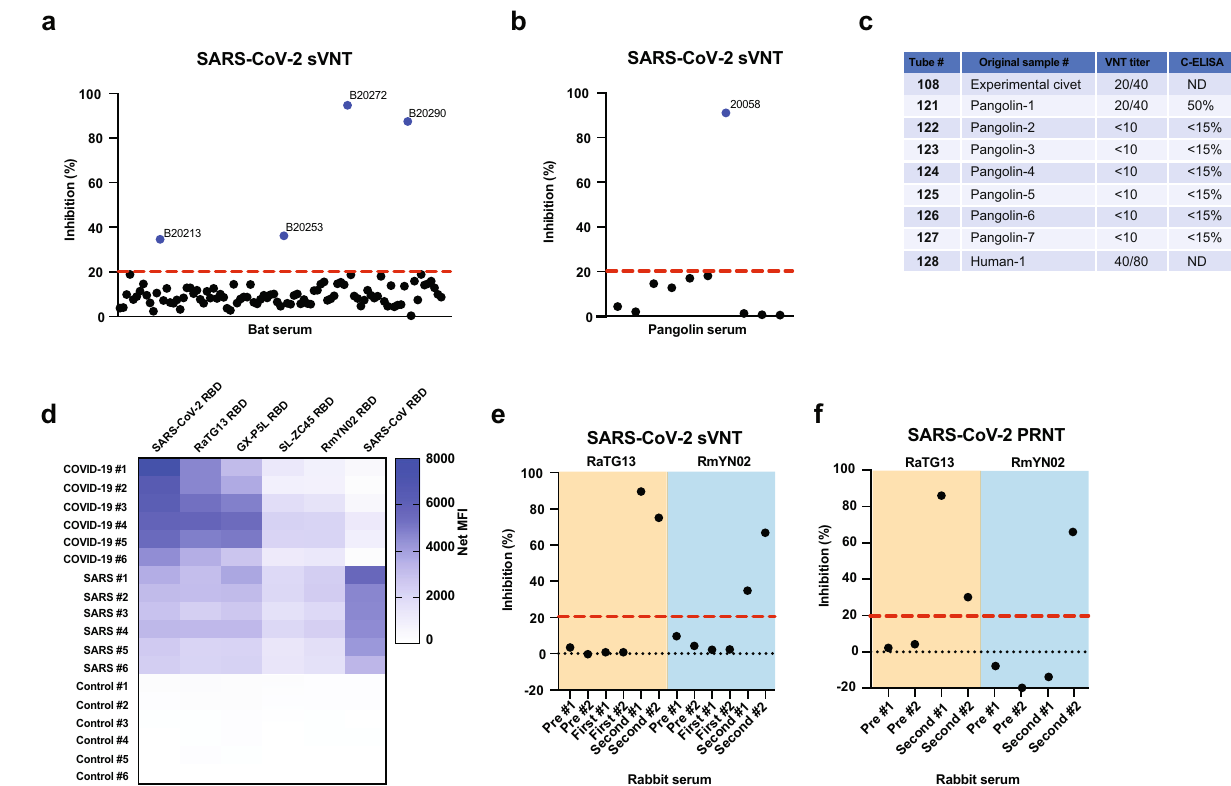
Fig. 3 Serological investigation. a SARS-CoV-2 sVNT results from bat sera in Thailand. b SARS-CoV-2 sVNT results from pangolin sera in Thailand. c SARS-CoV VNT and C-ELISA testing for pangolin sera sampled from animals originated from Southeast Asia. d Multiplex-RBD binding study to examine antigenic cross reactivity between human sera and different RBDs. e SARS-CoV-2 sVNT assay to examine cross-neutralization ability of different rabbit anti-RBD sera. Data indicate percentage of inhibition at 1:20 dilution. f SARS-CoV-2 PRNT assay to examine cross-neutralization ability of different rabbit anti-RBD sera. Data indicate percentage of inhibition at 1:10 dilution. Red dot line indicates cut-off at 20% inhibition. Pre indicates pre-immunized sera; First and Second indicates sera obtained post fi rst immunization and second immunization, respectively. All graphs and heatmap presented were generated using GraphPad Prism